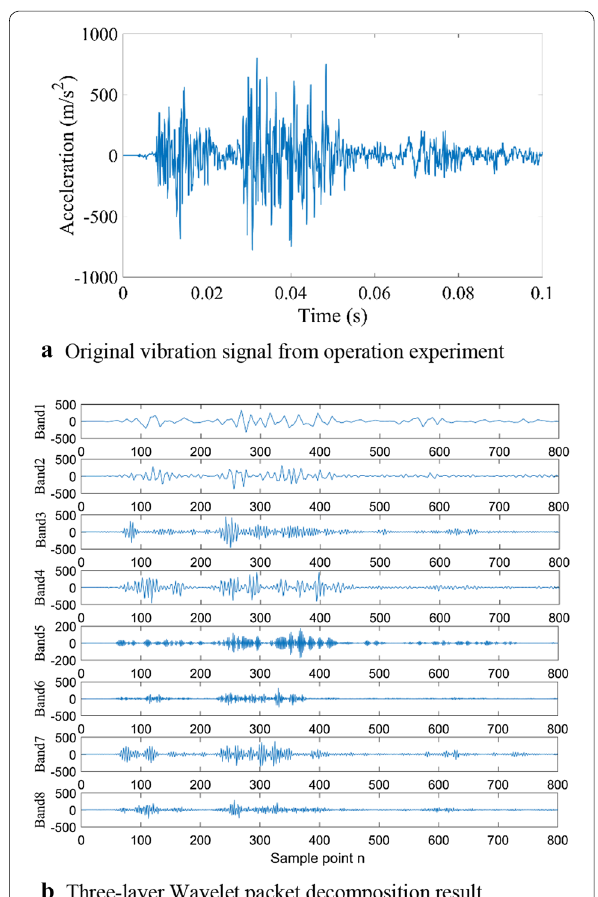
Figure 3 Vibration signal and relative detail